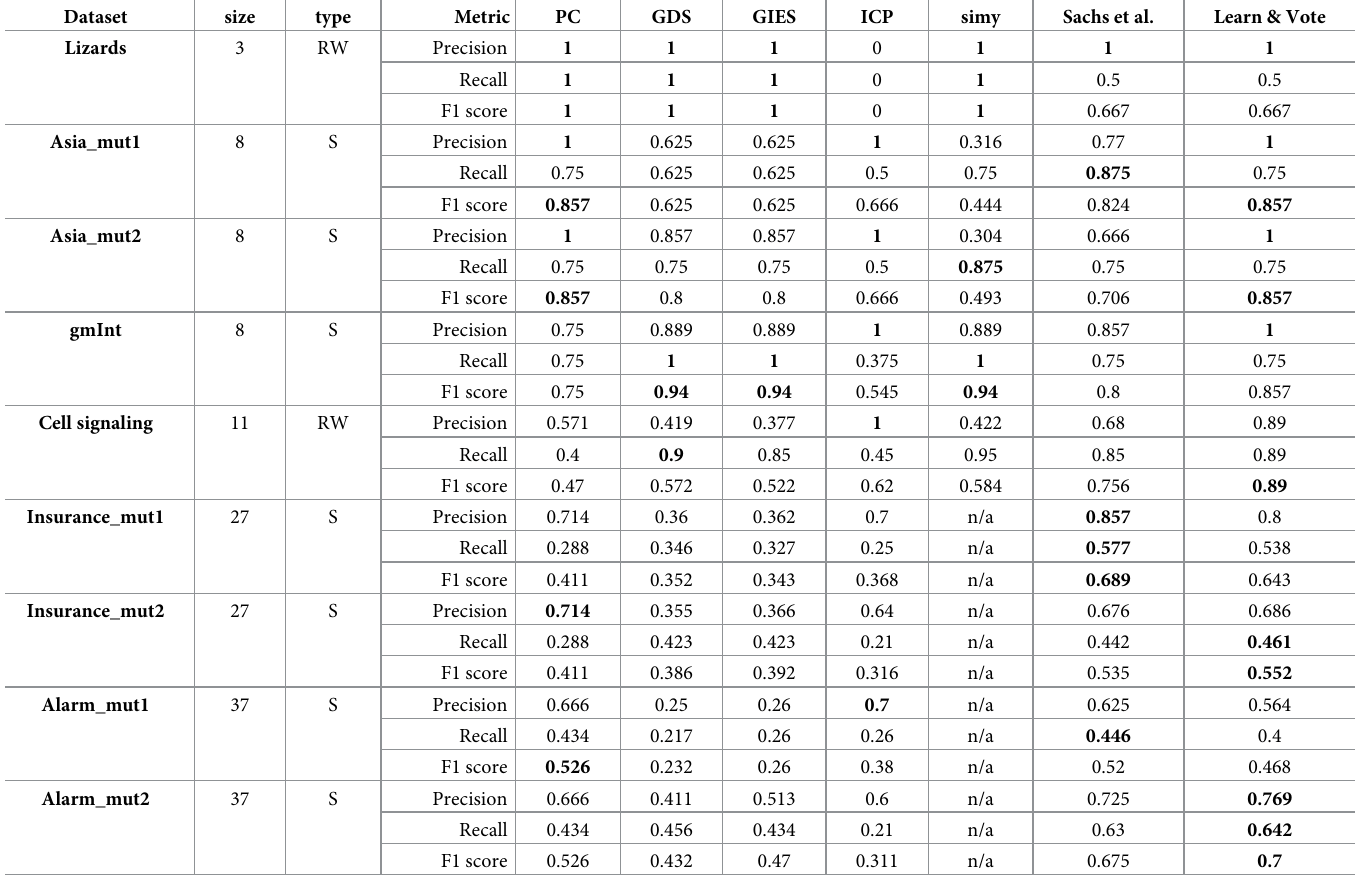
Table 1. Multi-dataset performance of “Learn & Vote” versus six other methods. Each row corresponds to a specific dataset derived from a specific underlying ground- truth network (as described in detail in Methods and Datasets). Each row is split into three structure learning performance metrics (precision, recall, and “F1” score, har- monic mean of precision and recall). For each sub-row, the highest performance measurement is boldfaced. Each column corresponds to a specific method for causal net- work inference (as described in detail in Methods and Datasets), with the performance measures of our method (“Learn and Vote”) in the rightmost column. The symbol “n/a” denotes that no performance results were available for that method on that dataset. Here, the method “simy” is only feasible for networks containing up to 20 nodes, so it failed to produce results on the larger networks. The network size denotes the number of nodes in the indicated network. The network type is as follows: RW, real- world; S, synthetic.